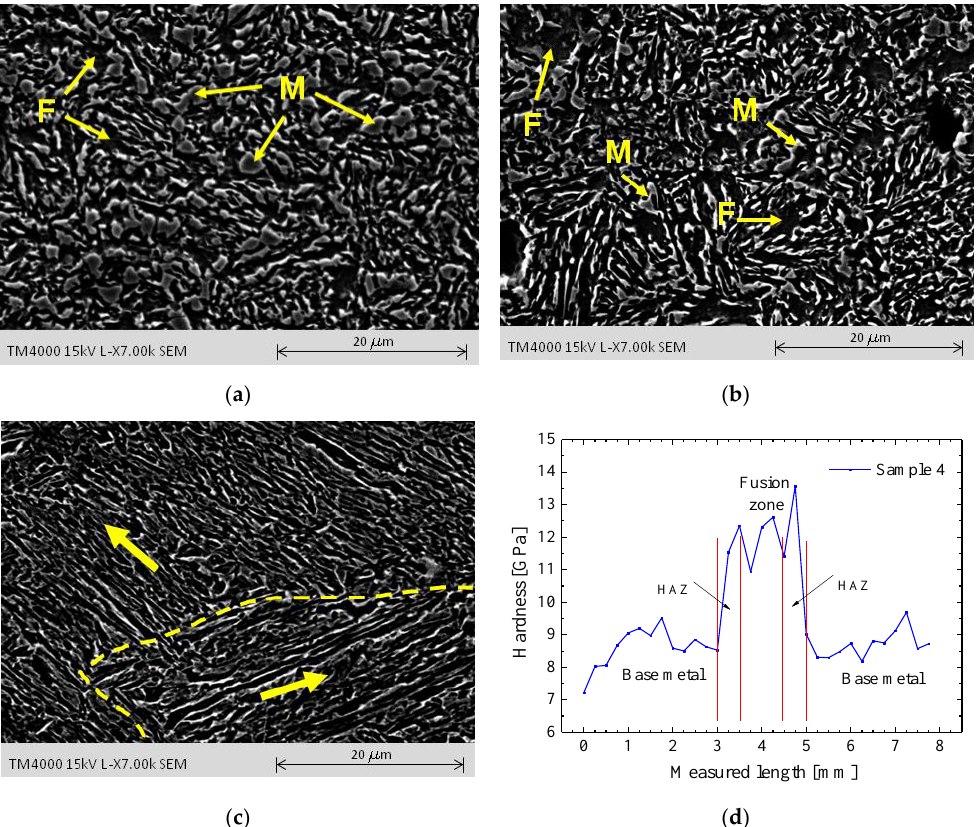
Figure 11. SEM micrographs of Sample 3: ( a ) base metal, ( b ) HAZ, ( c ) fusion zone, and ( d ) nano- Figure11. SEMmicrographsofSample3: ( a )basemetal, ( b )HAZ,( c )fusionzone, and( d )nano-hardness hardness profile across to the weld bead. profile across to the weld